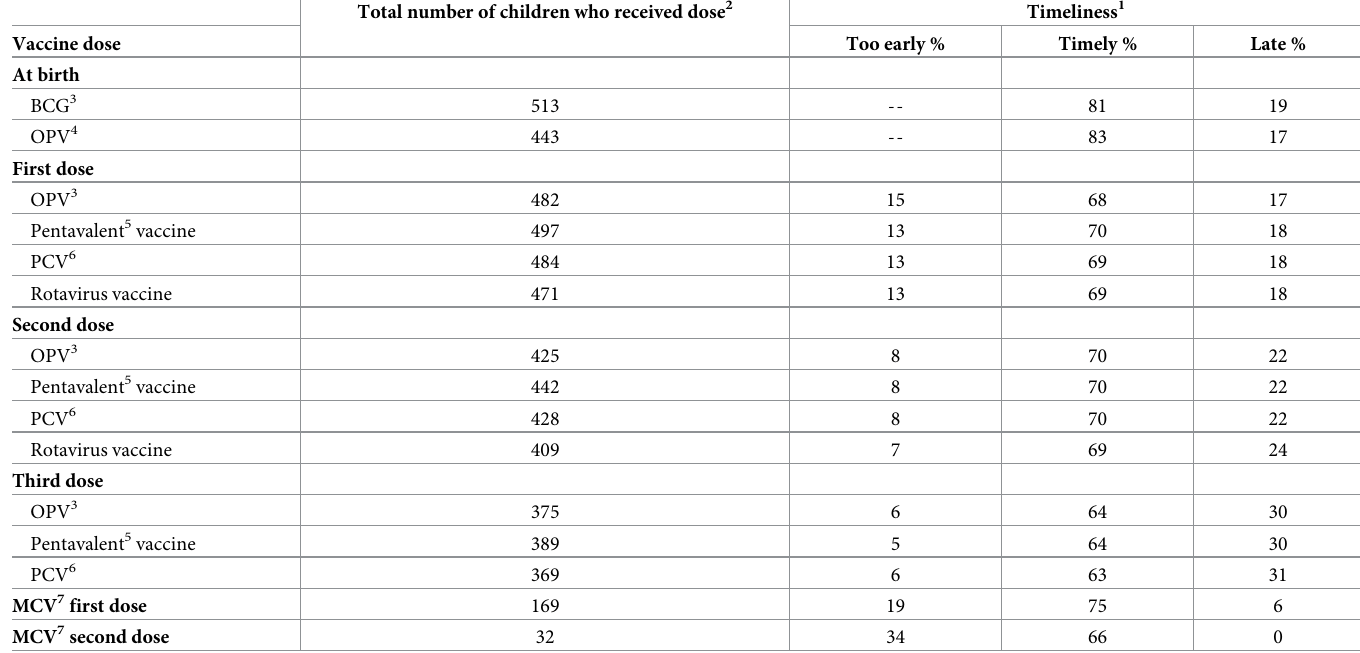
Table 4. Timeliness of vaccine doses administered to surveyed children with documented vaccination histories, missed opportunities for vaccination (MOV) assess- ment, Kenya,